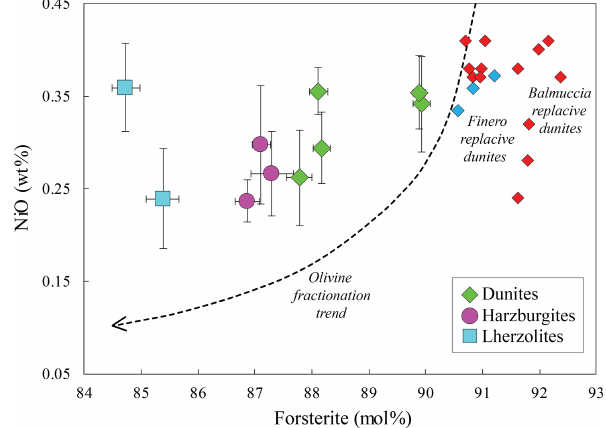
Figure 7. Plot of NiO (wt%) versus forsterite proportion (mol%) of olivine from the Rocca d’Argimonia peridotites. Data are aver- aged per sample; error bars represent the standard deviation of the mean value (2 σ ). The compositions of olivine from mantle replacive dunites of the Balmuccia and Finero mantle sequences (Mazzuc- chelli et al., 2009; Bussolesi et al., 2019; Corvò et al., 2020) are reported for comparative purposes. Olivine fractionation trend after Su et al.